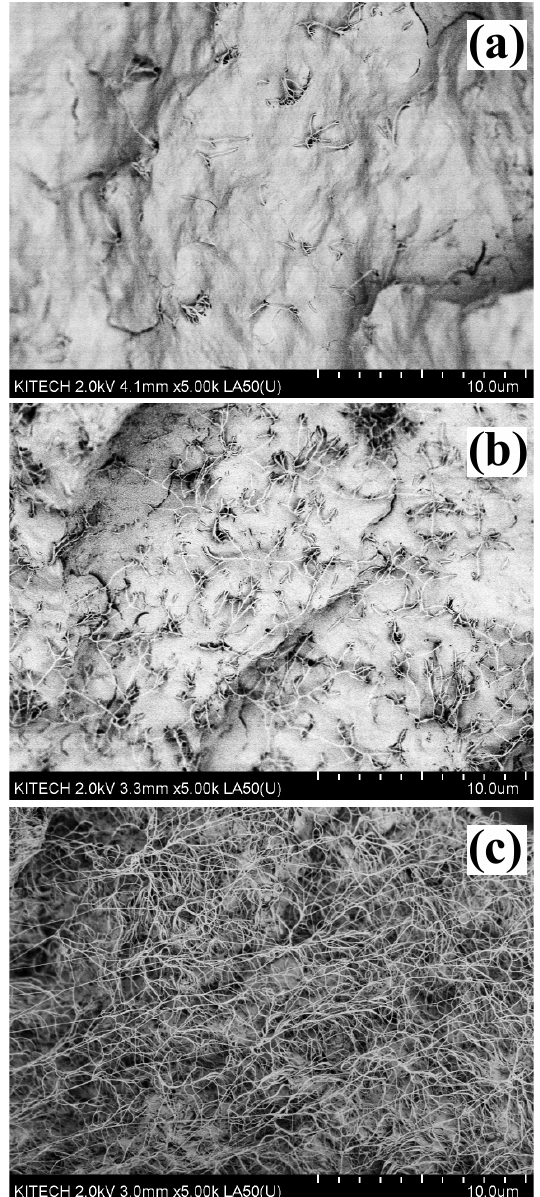
Figure 6. SEM images of ( a ) 0.29 wt.%, ( b ) 1.28 wt.%, and ( c ) 6.56 wt.% SWNT in the composite.